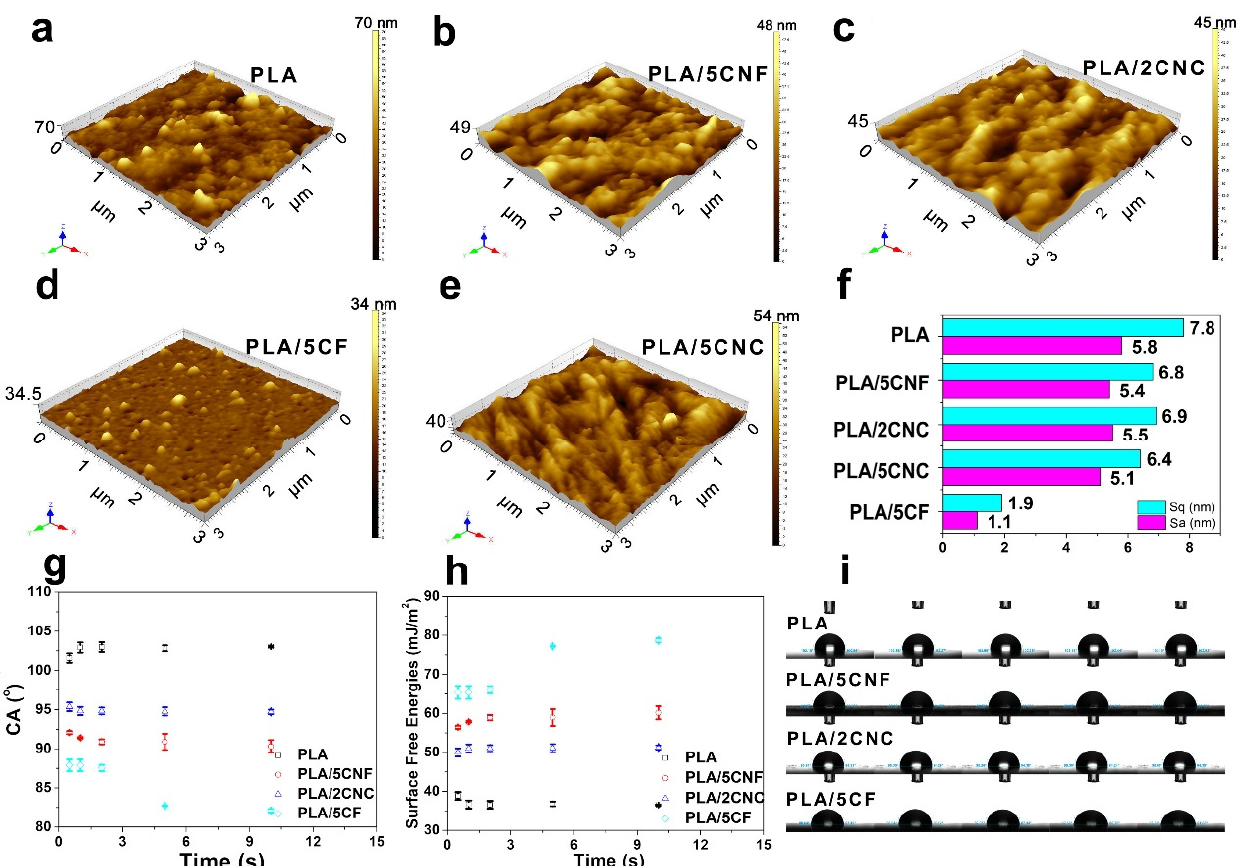
Figure 4. Three-dimensional, plotted images of neat PLA film ( a ), PLA/5CNF ( b ), PLA/2CNC ( c ), PLA/5CF ( d ), PLA/5CNC ( e ), respectively; Roughness (Sq) and average height (Ra) ( f ), water contact angle ( g ), surface free energies ( h ), and digital photo ( i ) of PLA film and PLA composite films.